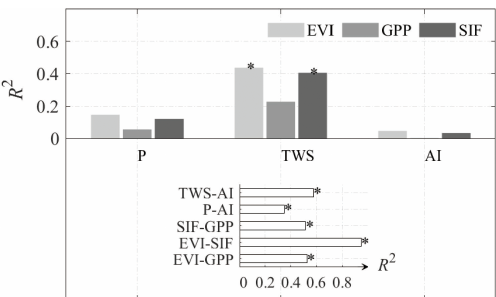
Figure 5. Coefficient of determination ( R 2 ) from linear regressions between the basin-averaged anomalies of P , TWS, AI, EVI, SIF, and GPP at the annual scale. The asterisk indicates p < 0 .